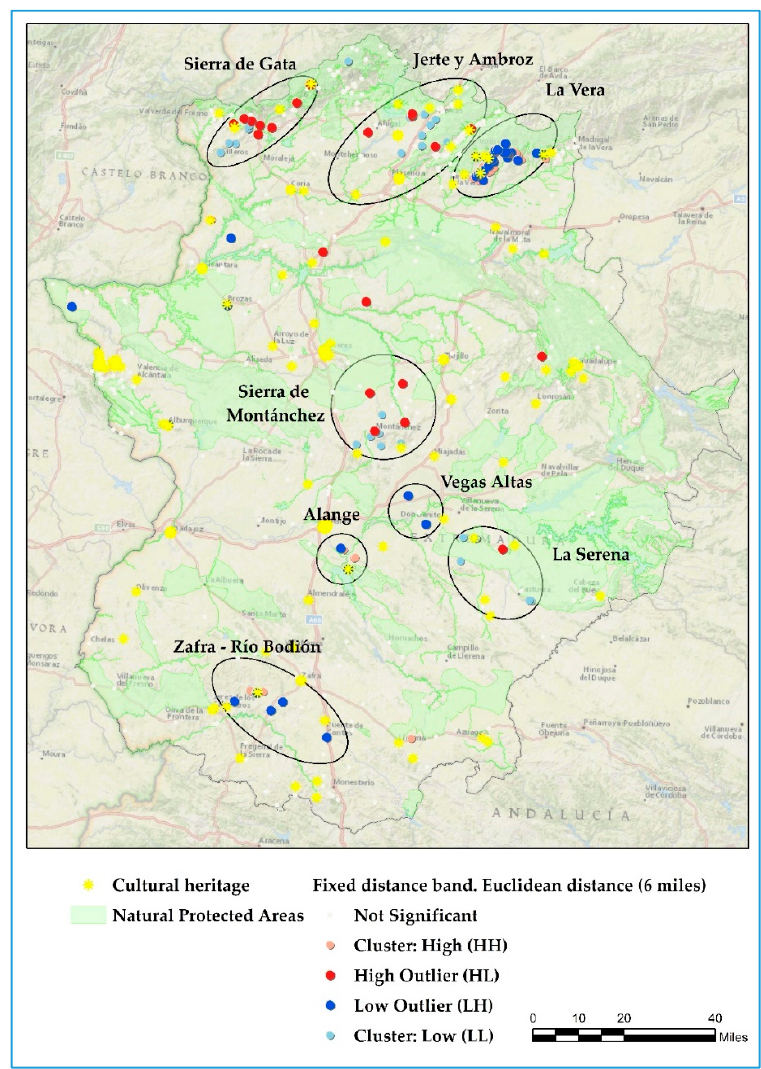
Figure 8. The results of the cluster and outlier analysis.